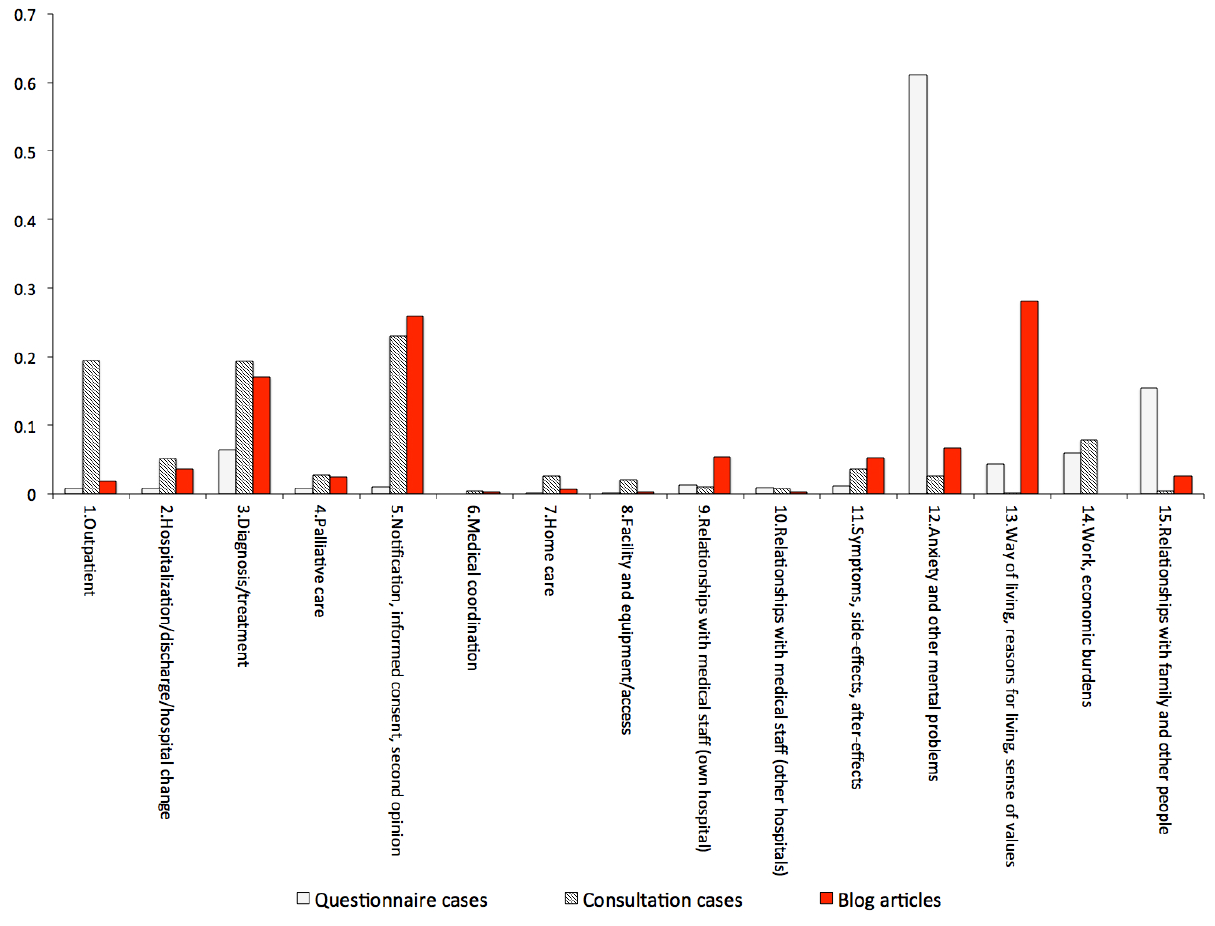
Figure 1. Results of comparison of previous studies and blog